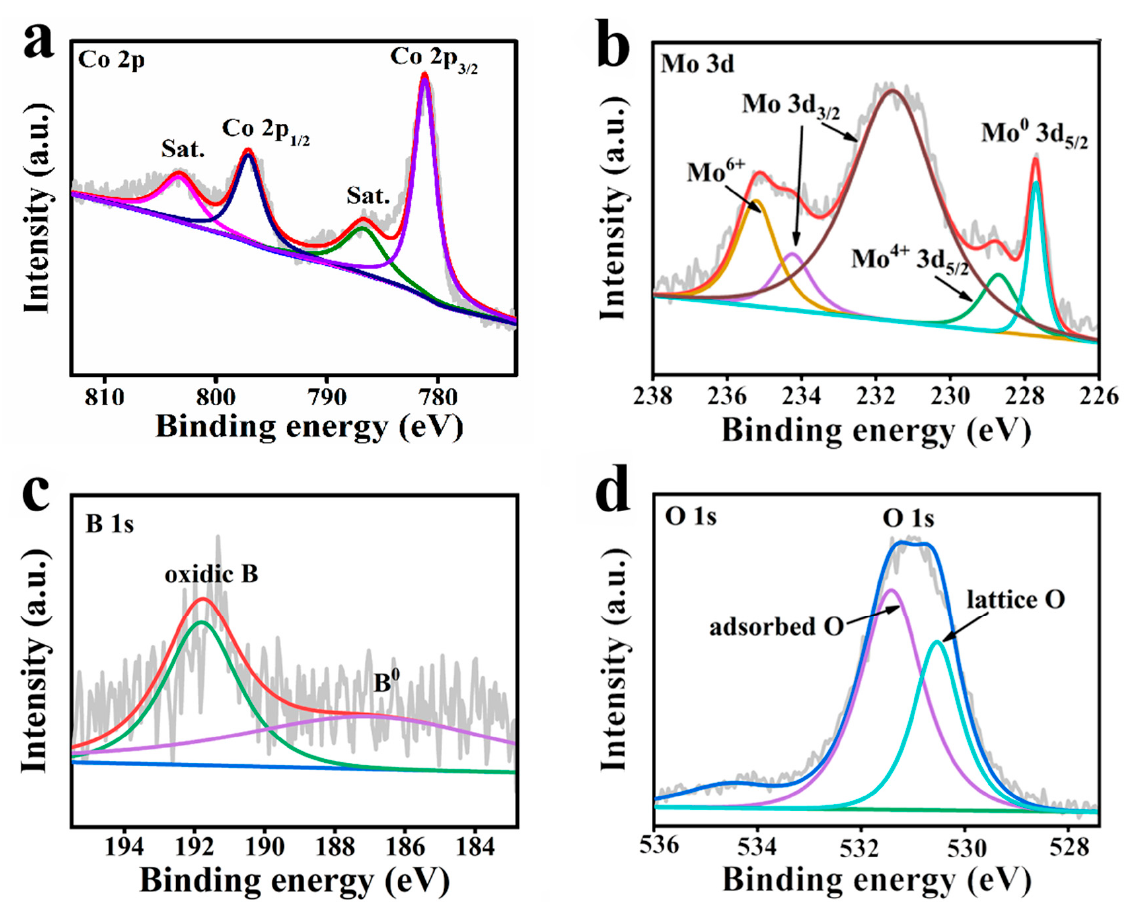
Figure 2. The refined XPS survey for Co-Mo-B/NF in ( a ) Co 2p, ( b ) Mo 3d, ( c ) B 1s, and ( d ) O 1s regions.